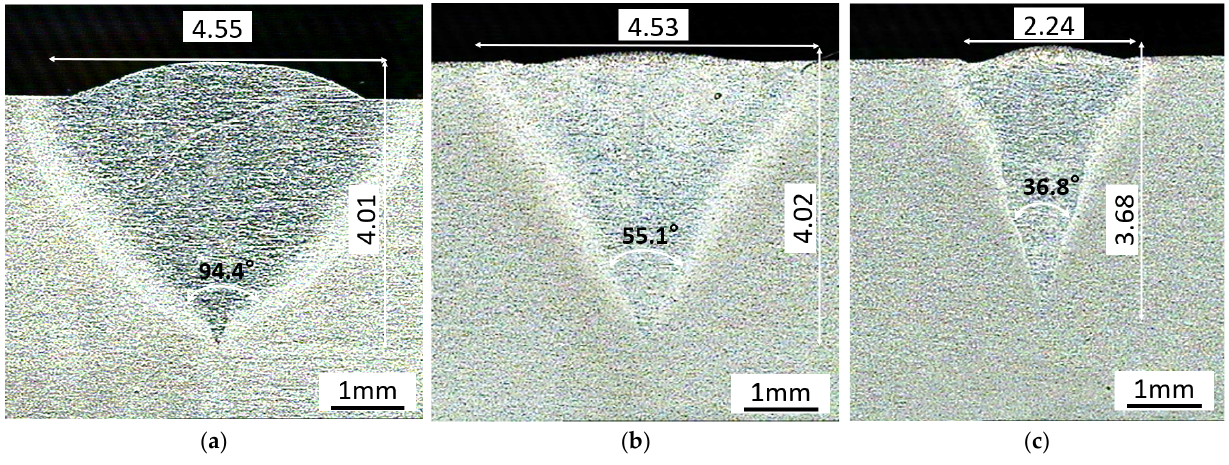
Figure 3. The molten pool figure of normal laser melting and deep penetration: ( a ) CW ‐ 800W ( b ) PWM ‐ 800W ‐ L, ( c ) PWM ‐ 800W ‐ H. Table 3. Parameters of the molten pool.